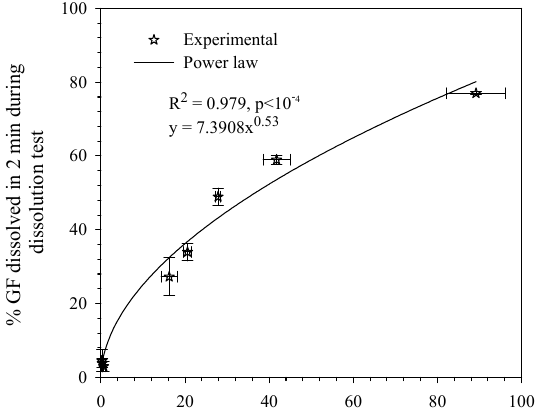
Figure 11. A correlation between percentage of GF dissolved in 2 min in the USP II dissolution test and percentage of GF nanoparticles recovered in 2 min during the agitated redispersion test with a paddle stirrer. Markers correspond to various dispersant formulations in the GF nanocomposites prepared by fluidized bed coating of wet media milled GF suspensions on Pharmatose. The redispersion–dissolution medium is water. (Adapted from Bhakay et al. [8] with permission from Taylor & Francis Ltd., www.tandfonline.com.